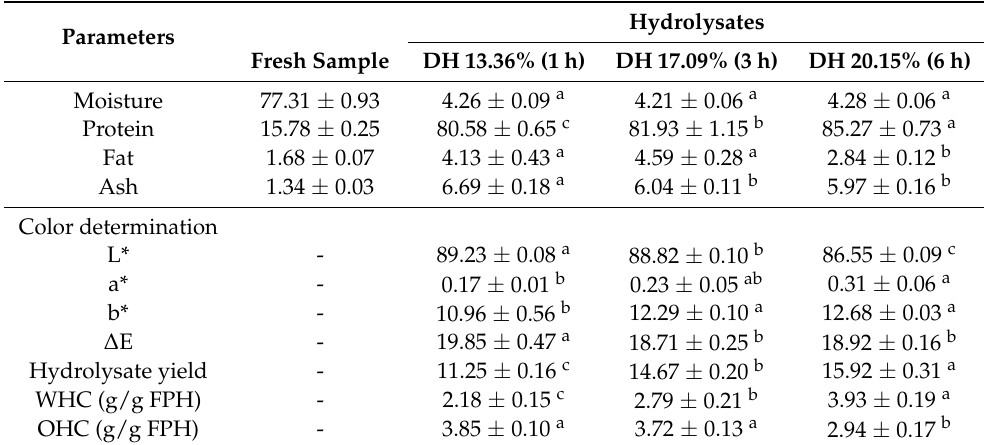
Table 2. Proximate composition, color measurement, yield, and WHC and OHC of bighead carp fresh muscles and protein hydrolysates (FPH) prepared using ficin enzyme ( n = 3, mean ± SD). Hydrolysates Parameters Fresh Sample DH 13.36% (1 h) DH 17.09% (3 h) DH 20.15% (6 h) Moisture 77.31 ± 0.93 4.26 ± 0.09 a 4.21 ± 0.06 a 4.28 ± 0.06 a Protein 15.78 ± 0.25 80.58 ± 0.65 c 81.93 ± 1.15 b 85.27 ± 0.73 a Fat 1.68 ± 0.07 4.13 ± 0.43 a 4.59 ± 0.28 a 2.84 ± 0.12 b Ash 1.34 ± 0.03 Color determination L* - 89.23 ± 0.08 a 88.82 ± 0.10 b - b* - 10.96 ± 0.56 b 12.29 ± 0.10 a 12.68 ± 0.03 a ∆ E - 19.85 ± 0.47 a 18.71 ± 0.25 b 18.92 ± 0.16 b Hydrolysate yield - 11.25 ± 0.16 c 14.67 ± 0.20 b WHC (g/g FPH) -